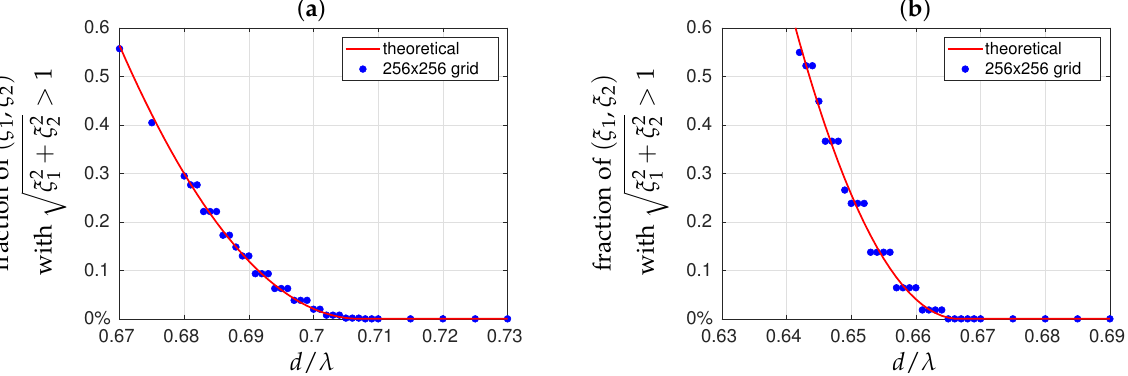
Figure 3. Variations of the fraction of directions ξ without physical or mathematical meaning with the shortest spacing d between the antennas of arrays leading to ( a ) a Cartesian geometry and to ( b ) a hexagonal geometry. Shown in red are the theoretical variations and with blue bullets the values calculated for sampling grids with 256 × 256 directions (or pixels) in the synthesized field of view. In every case, two regions are well-separated: in the first one this fraction is strictly equal to zero, whereas in the second one it is a growing function of the inverse of the shortest spacing. The frontier between these regions is estimated between 0.704 λ and 0.705 λ in ( a ) and between 0.664 λ and 0.665 λ in ( b